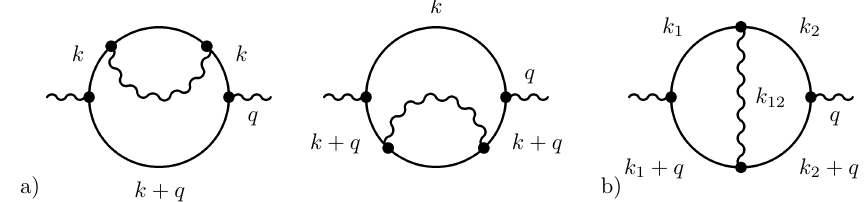
Figure 3. The diagrams contributing to the shaded blob is shown in Figure 2. Symbols ( a ) and ( b ) correspond to the different topologies of the corrections to the polarization